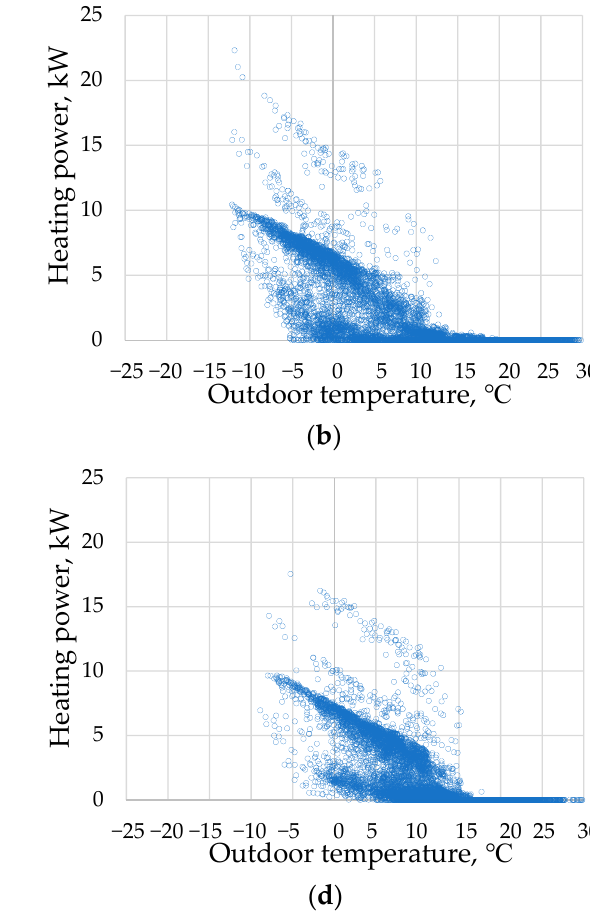
Figure 4. Illustration of the non-existing base temperature of heating degree day (HDD) for different climates; the plot of hourly heating powers ( a ) Tallinn, ( b ) Sapporo, ( c ) Paris, and ( d ) Brussels.